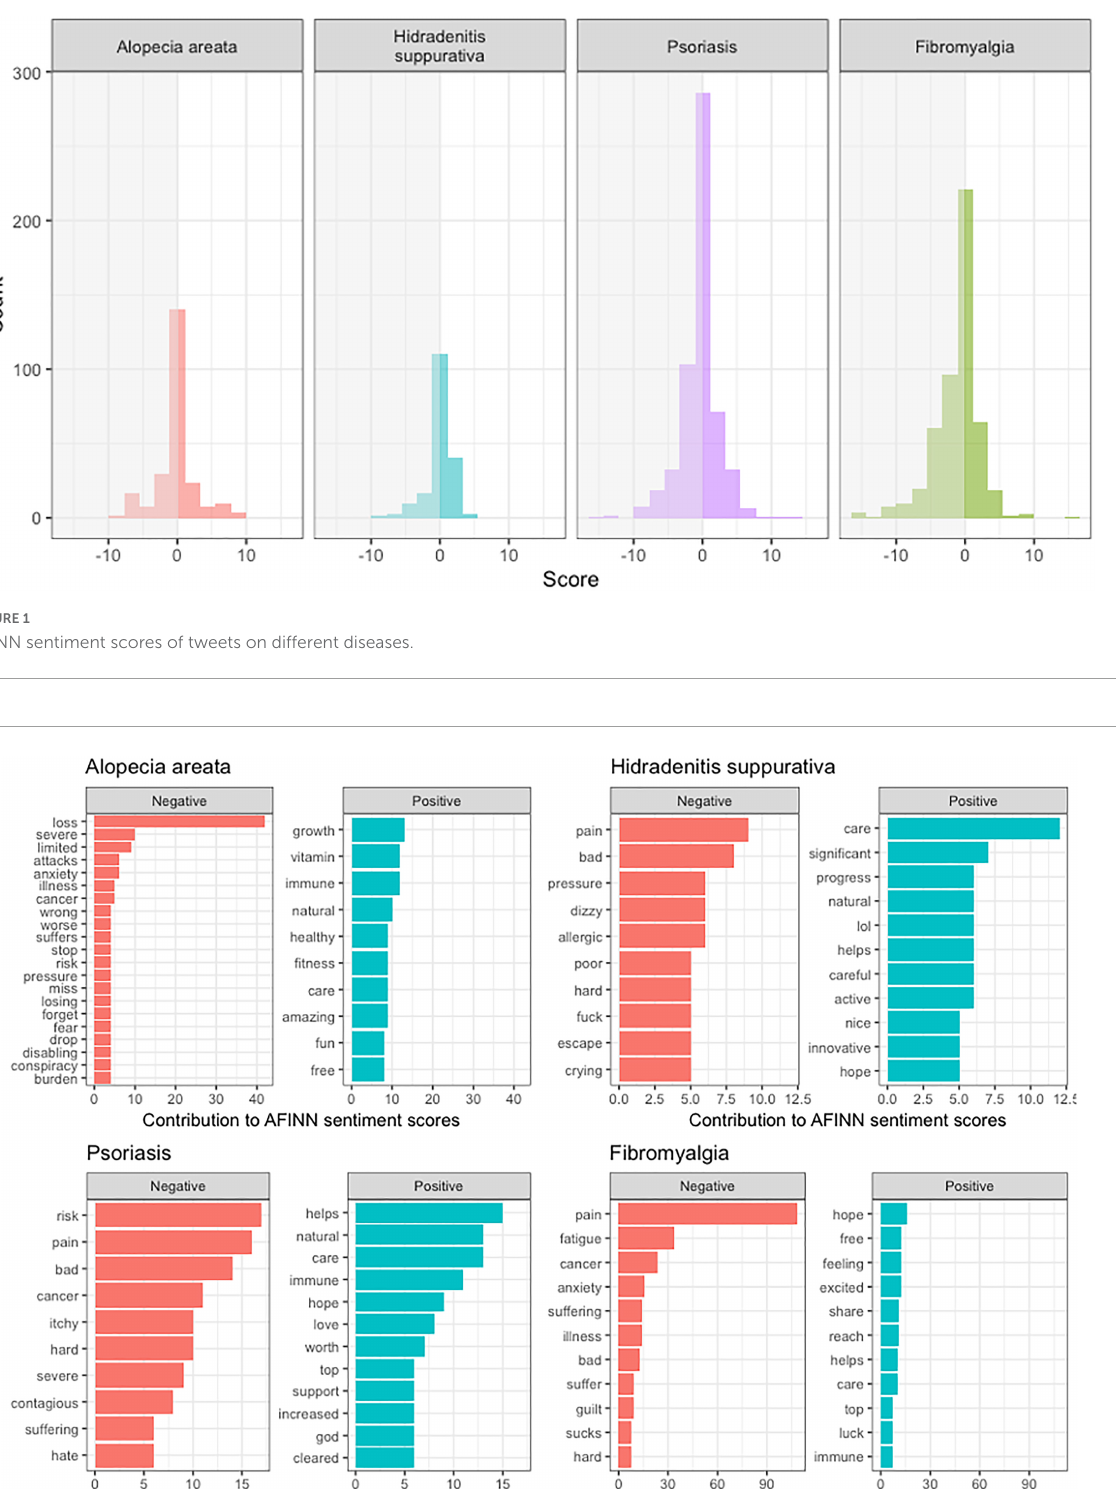
FIGURE2 AFINN lexicon-graded positive and negative words commonly used in tweets about different